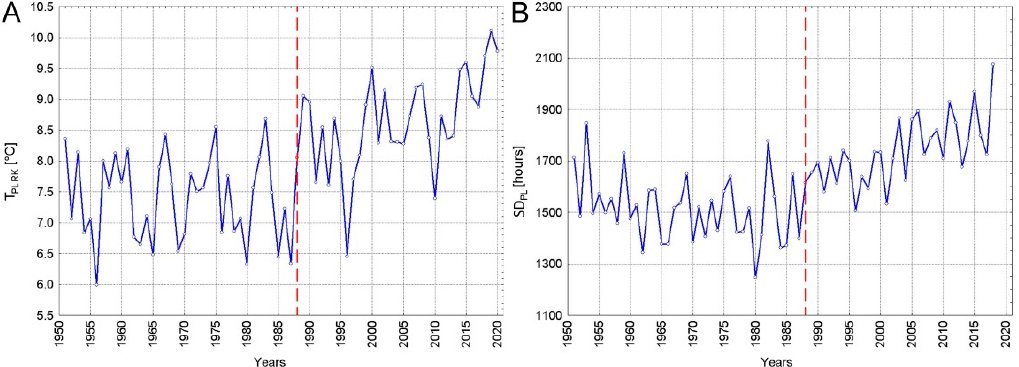
Figure 3. Courses of the annual area air temperature (T PL ) ( A ) and sunshine duration (SD PL ) ( B ) in Poland in 1951–2020. The year 1988, when the courses changed and a positive trend appeared, is marked with the vertical dashed line.